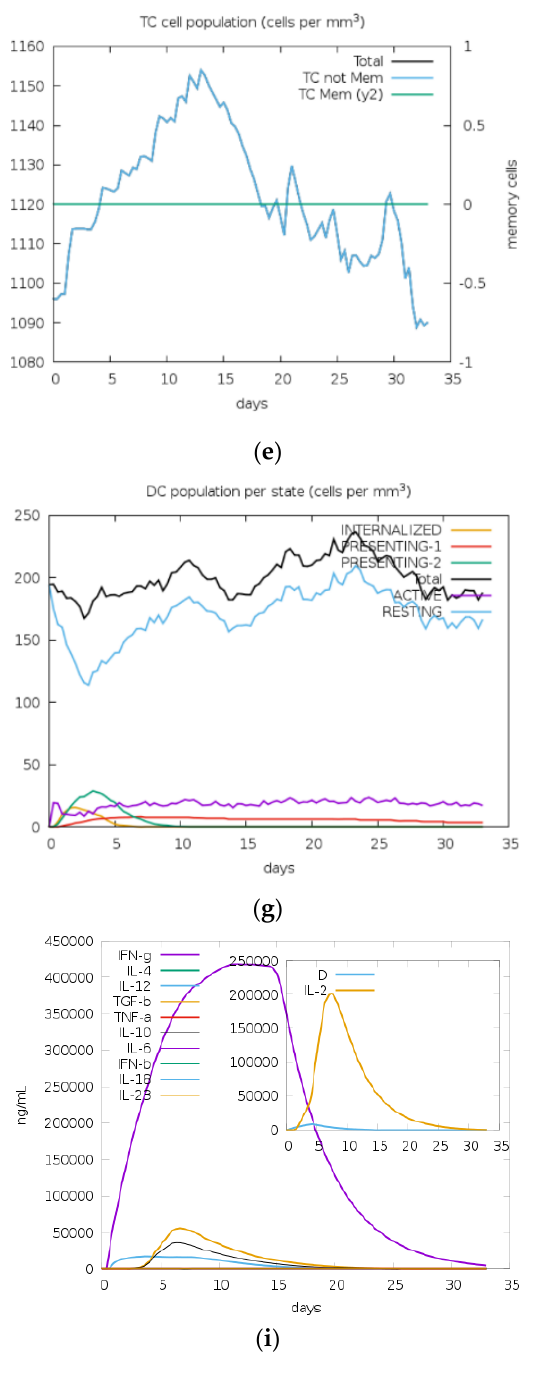
Figure 6. Immune simulation result of the vaccine construct showing clear immune system activity against the vaccine. Simulation of B cells ( a , b ), T cells ( c – f ), Dendritic cells ( g ), antibodies ( h ), and various cytokines ( i ). IFN: Interferon, IgM/G: Immunoglobulin M/G, IL: Interleukins, TNF: Tumor necrosis factor, TGF: Transforming growth factor, TC cells: Cytotoxic T cells, TH cells: T-helper cells. Y2: Scale of Memory Cells, B Mem: Memory B cells, TH Mem: Memory T-helper cells. Codon optimization yielded the nucleic acid sequence of 516 base pairs with 54.26% GC content. These were cloned in silico using the SnapGene tool in the pShuttle-CMV vector (Figure